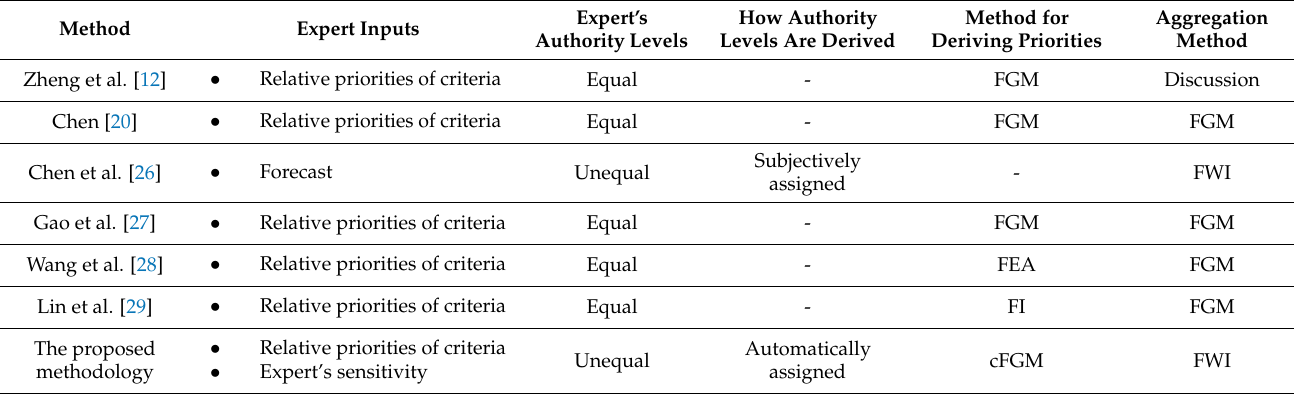
Table 1. Differences between the proposed methodology and some existing methods.